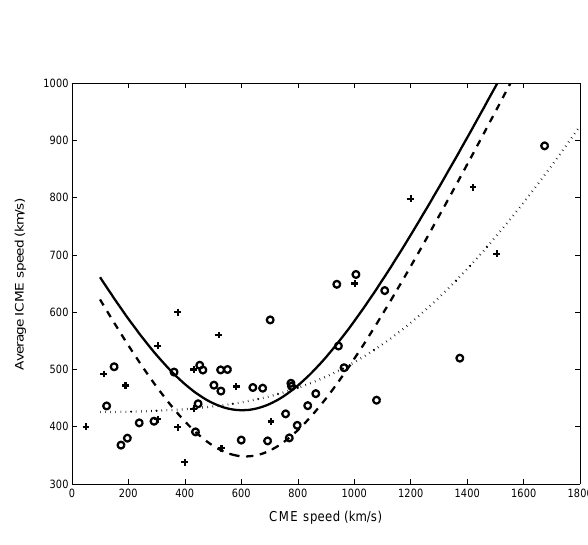
Fig. 3. The CME speed as a function of the average ICME speed at 1AU for the 35 events observed along the Earth-Sun line (“o”s) and the 19 events observed in quadrature (“+”s). The solid, dashed and dotted lines represent the ICME speeds at 1AU predicted by models G2000, G2001 and VG2002,